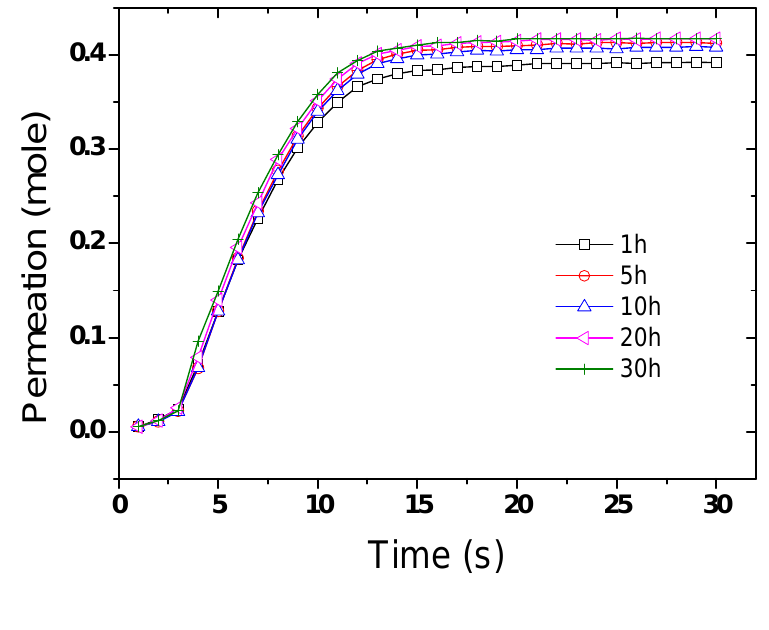
Figure 5. Dried air permeation across gold plated CNT BP. The corresponding plating times are given in hours in the